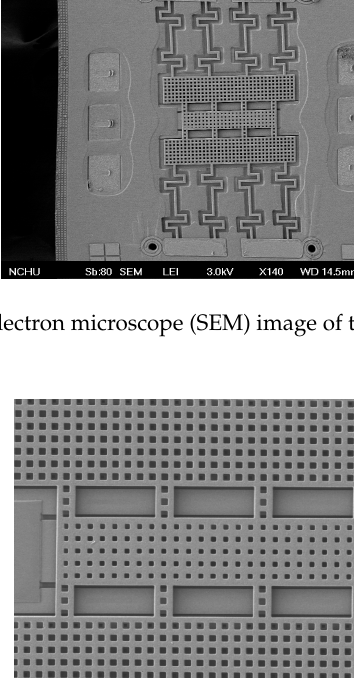
Figure 10. SEM image of the membrane.